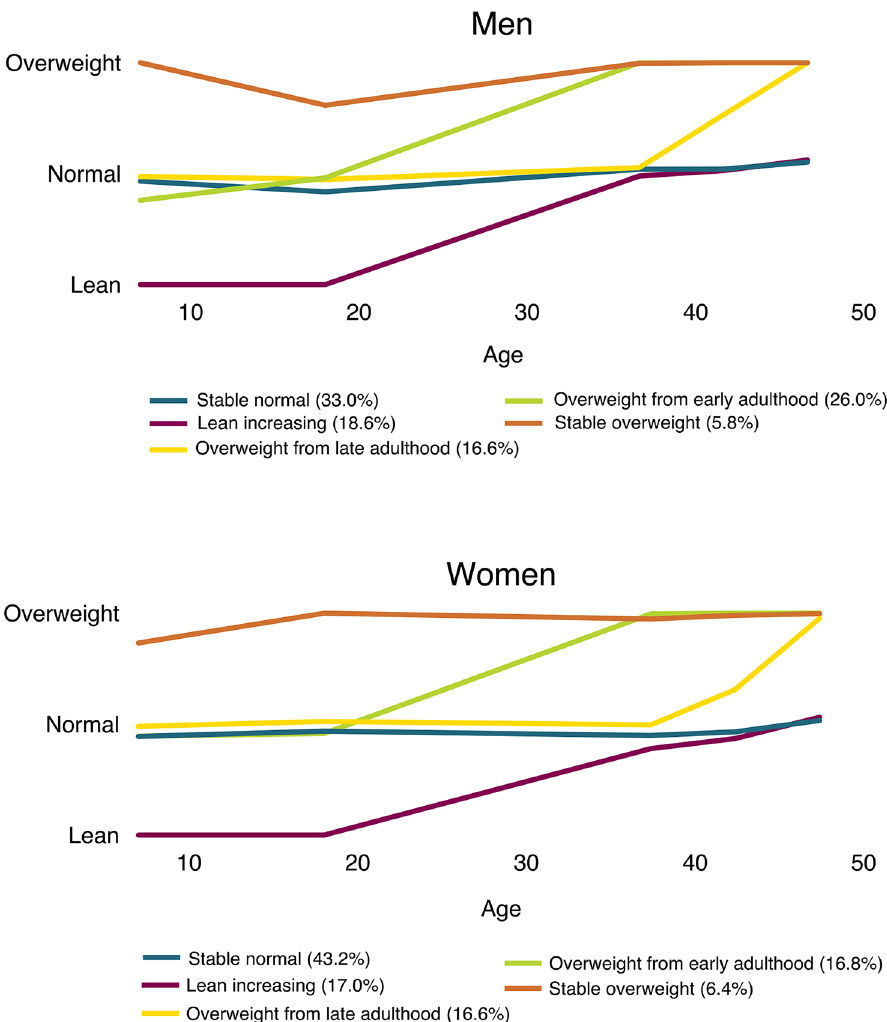
Figure 2. Life-course trajectories of weight categories by sex. The y-axis represents the probability of belonging to each weight category (lean, normal weight and overweight) estimated using group-based trajectory models. The predicted proportion of the population in each trajectory group is presented in